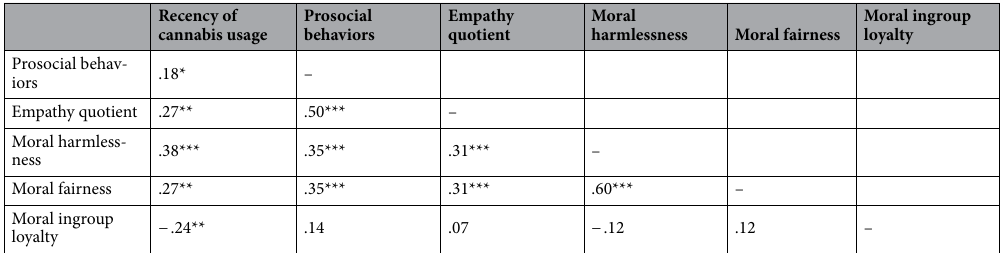
Table 3. Partial correlations between latency since last cannabis use and prosocial behaviors, empathy quotient, and moral foundations of harmlessness, fairness, and ingroup loyalty. n = 118, * p < .05, ** p < .01, *** p <